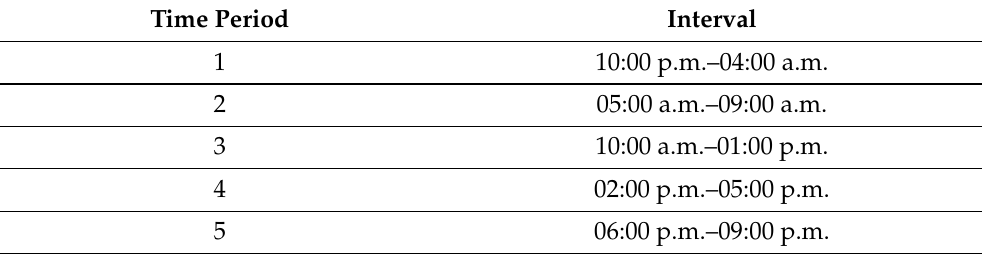
Figure 3. Time periods considered based on the behavior of the Paraguayan electricity demand. Table 1. Time periods for seasonal data set